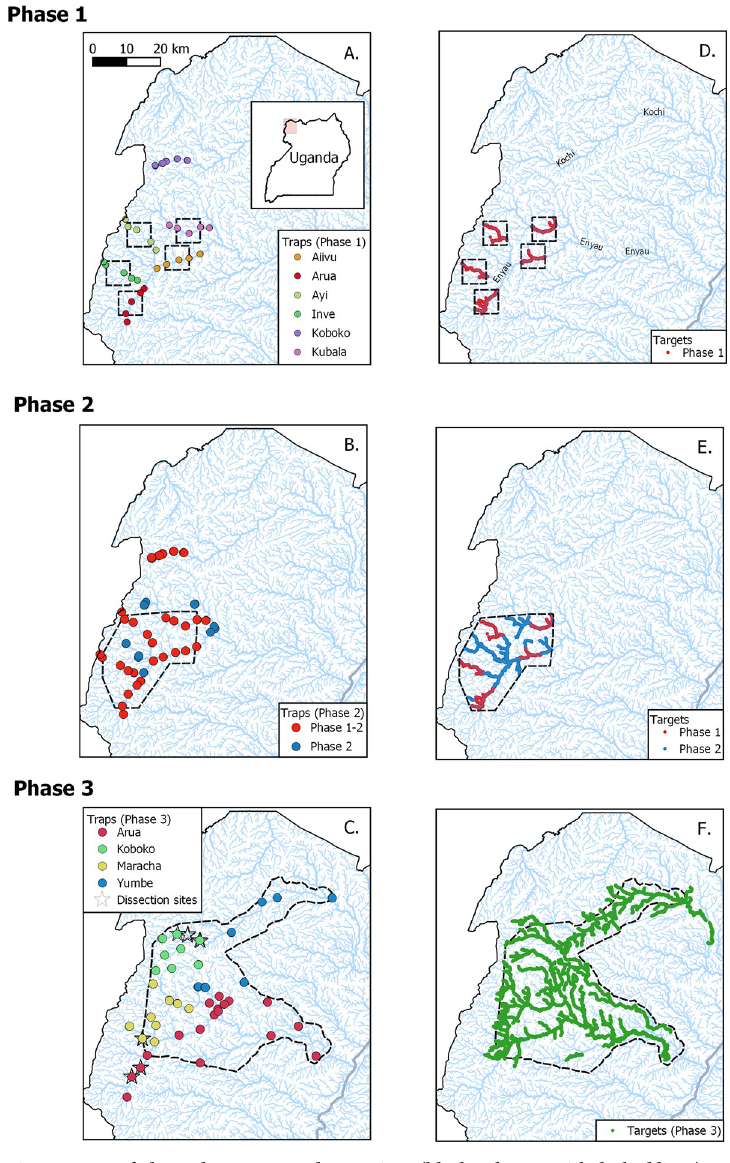
Fig 1. Extent of planned tsetse control operations (black polygons with dashed lines) and locations of monitoring traps and Tiny Targets deployed between 2011 and 2016. (A) Phase 1 (November 2011- November 2012): five square blocks, each 7 × 7 km. (B) Phase 2 (December 2012 –December 2014): single polygon of 500 km 2 ). (C) Phase 3 (January 2015 –December 2016): single polygon of 1636 km 2 . For C only, monitoring traps with stars indicate sites where tsetse were collected for dissection. D-F show, in (D) red, (E) red & blue or (F) green where targets were deployed in Phases 1–3; the untreated rivers and streams are shown in pale blue. Base layer of rivers is derived from